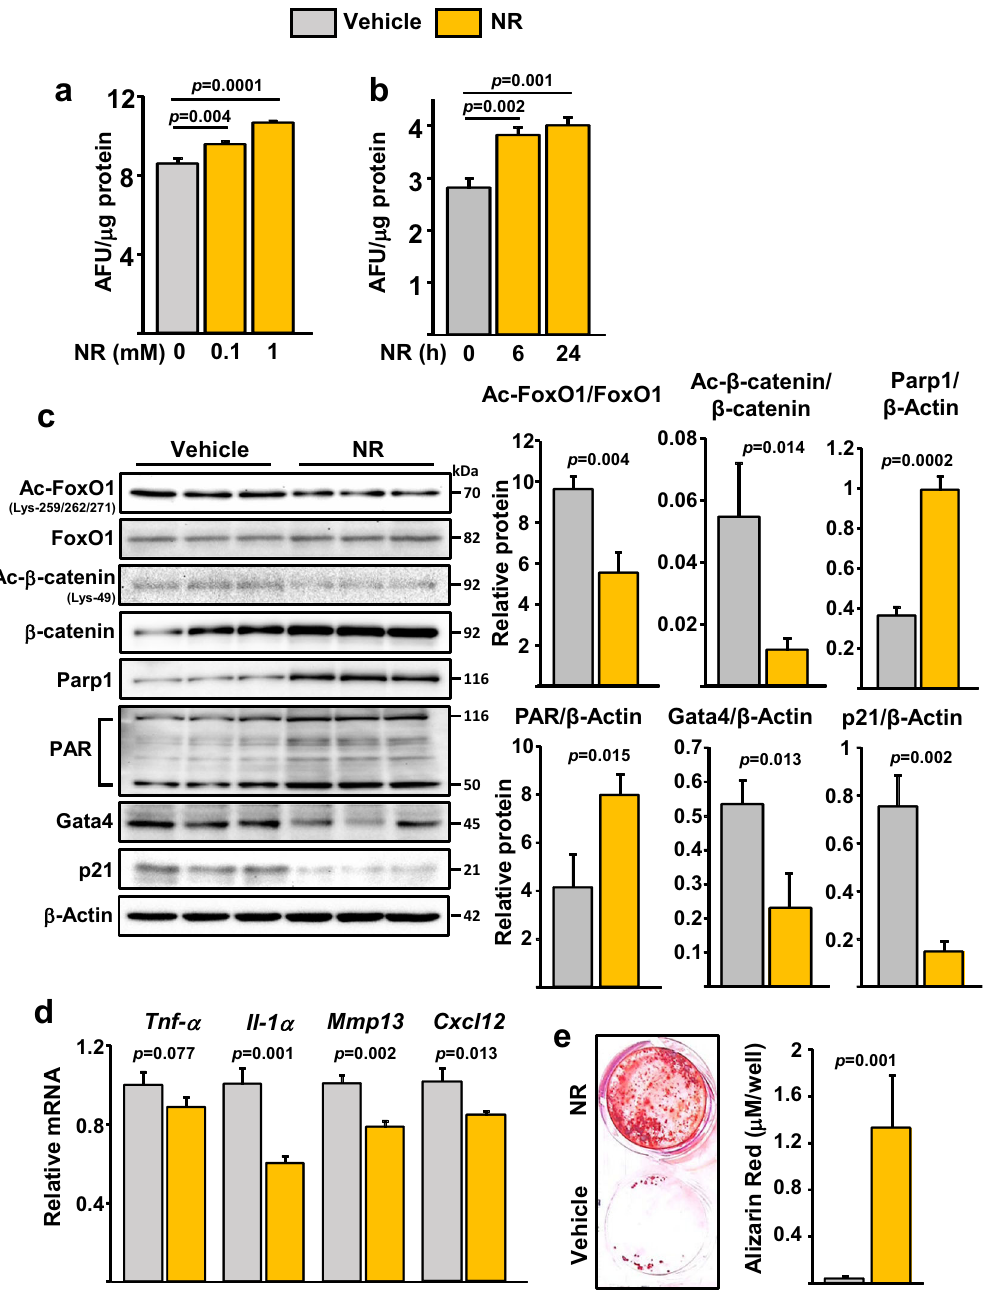
Fig. 2 NR attenuates cell senescence and defective osteoblastogenesis in cultured bone marrow cells from old mice. a , b NAD + levels in bone marrow stromal cells from 24-month-old C57BL/6 female mice cultured a with indicated doses of NR for 5 days and b with 1 mM NR for the indicated time period (triplicates). AFU arbitrary fl uorescence units. c Protein by western blot and d mRNA by qRT-PCR (triplicates) in cells cultured with 1 mM NR as in a . e Representative images (left) and quanti fi cation (right) of Alizarin Red staining of bone marrow stromal cells from 24-month-old C57BL/6 female mice cultured under osteogenic conditions for 21 days (triplicates) with or without 1 mM of NR. The data presented are mean ± SD using pooled cells from fi ve mice analyzed by one-way ANOVA ( a , b ) or Student ’ s t -test ( c , e